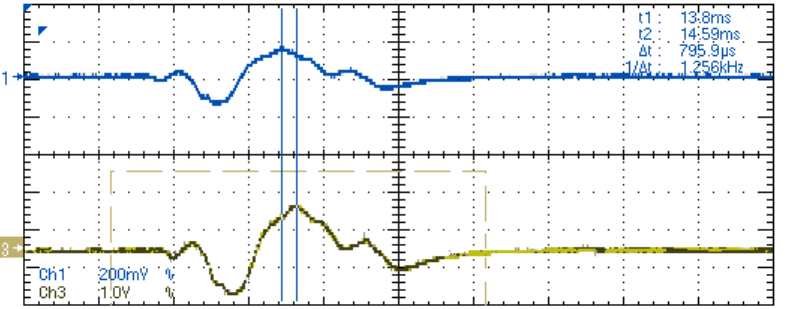
Figure 11. Delay between Transmitter input signal (blue curve), and Receiver embedded DAC output signal (olive green curve). Horizontal scale is